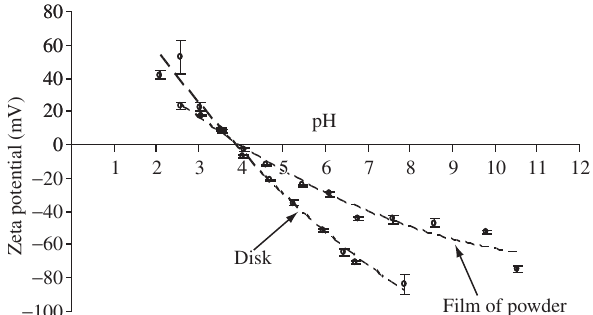
Figure 1. Zeta potential of films of acrylic commercial paints.